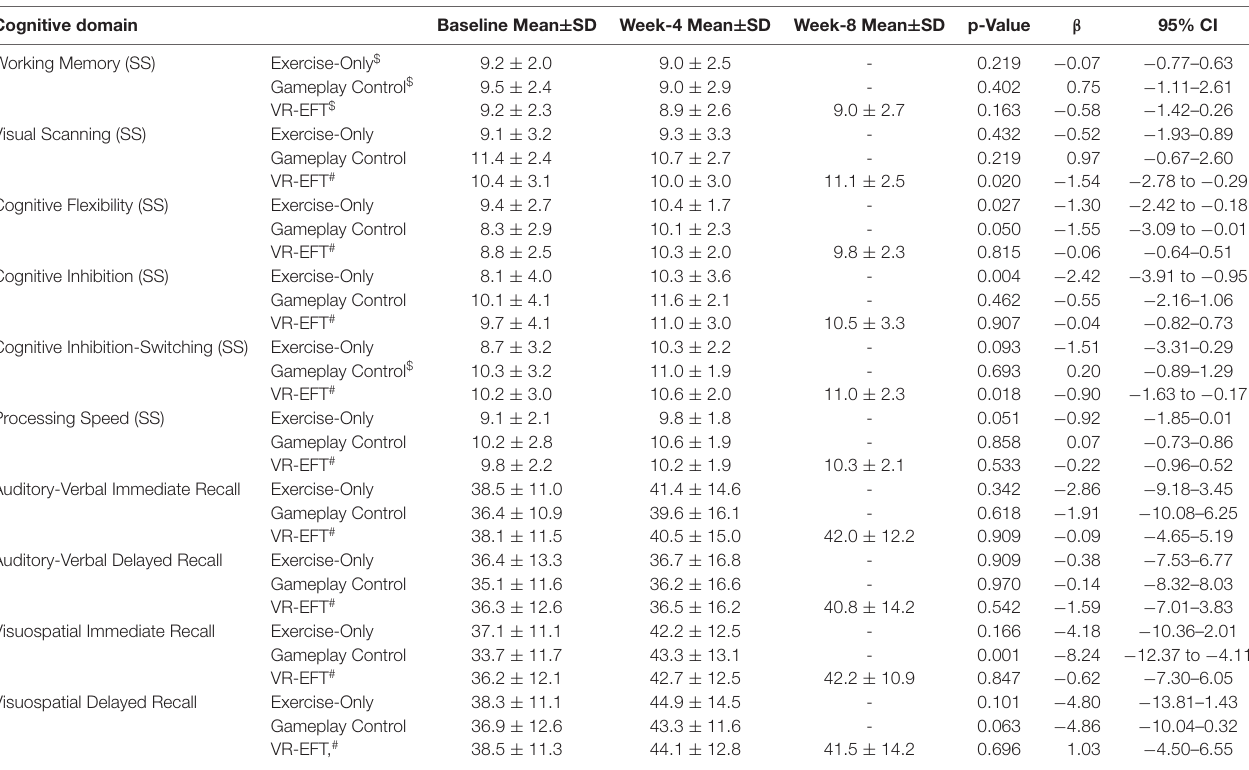
TABLE 2 | Secondary outcome: within group effects of cognitive function. Cognitive domain